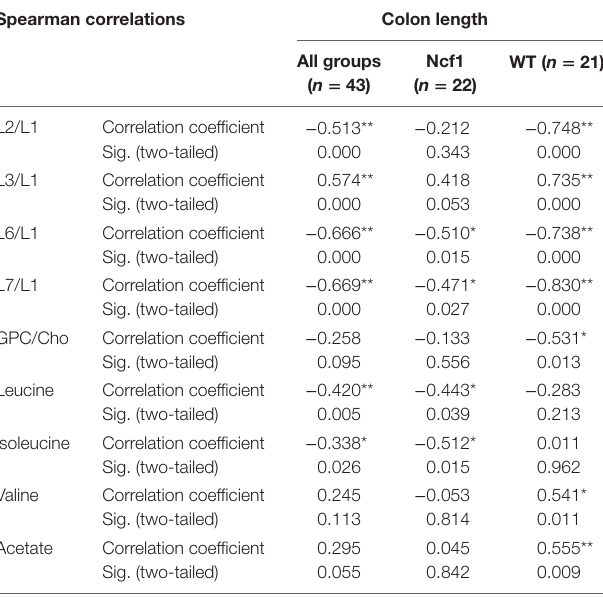
TaBle 5 | Summary of all statistically significant Spearman correlations for colon length vs metabolites concentrations considering either all mice pooled together or Ncf1 (Ncf1) vs wild-type (WT)